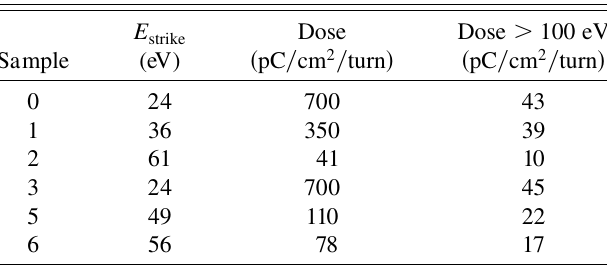
TABLE III. Parameters relevant to conditioning for TiN curves in Fig. 5.